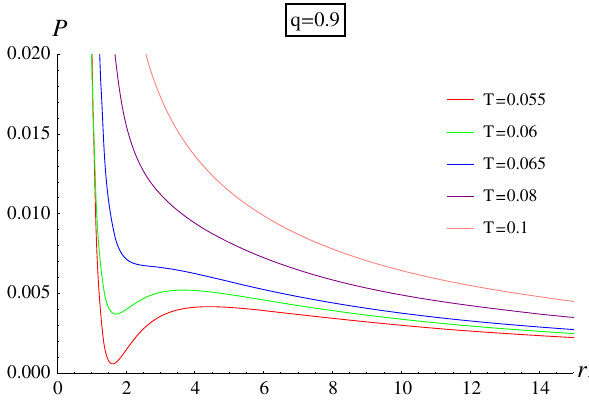
Fig. 8 The isotherms in the P − r + diagram at α = 0 . 5 and k = 0 . 4